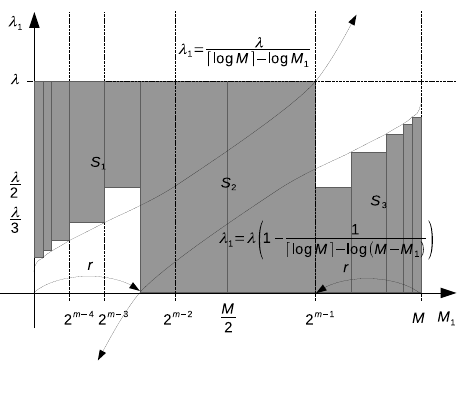
Fig. 3. Separability